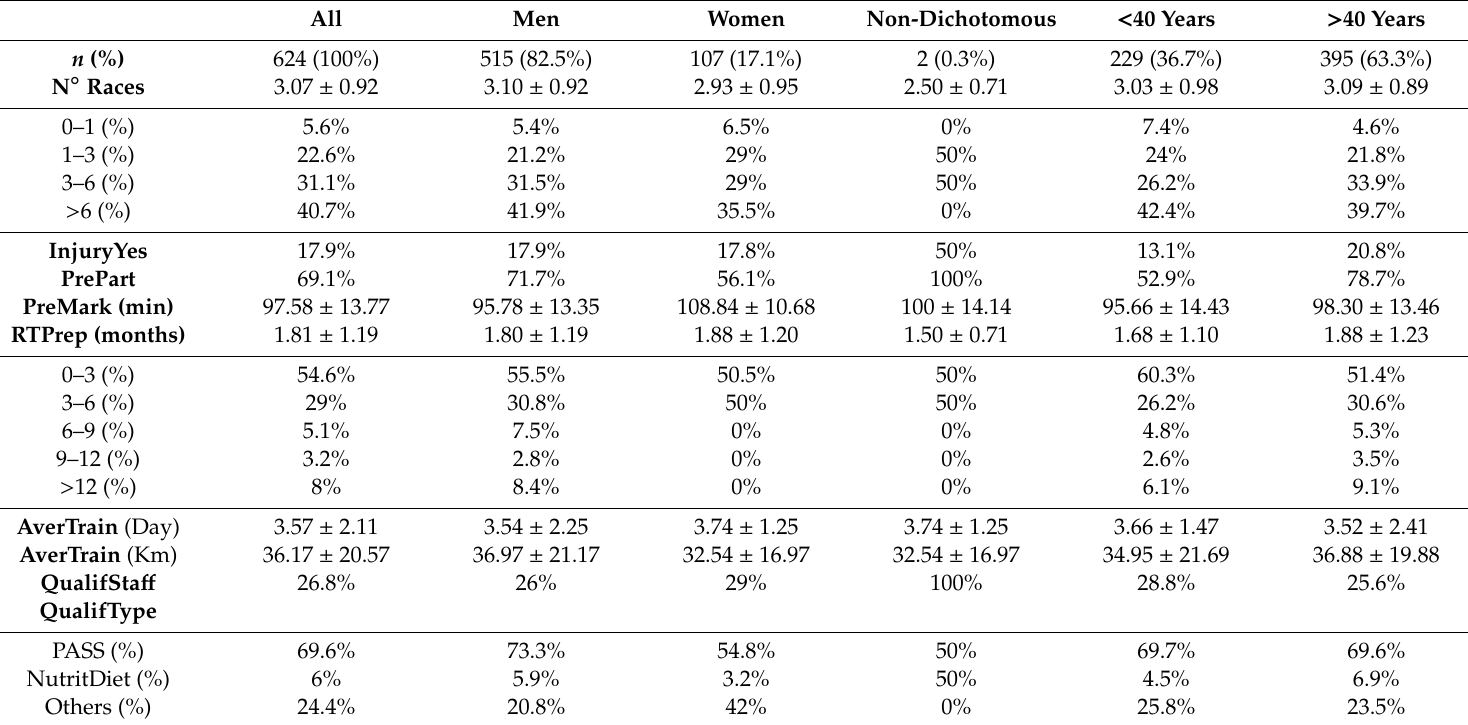
Table 1. Results of all the amateur half-marathon runners related to the generic and training